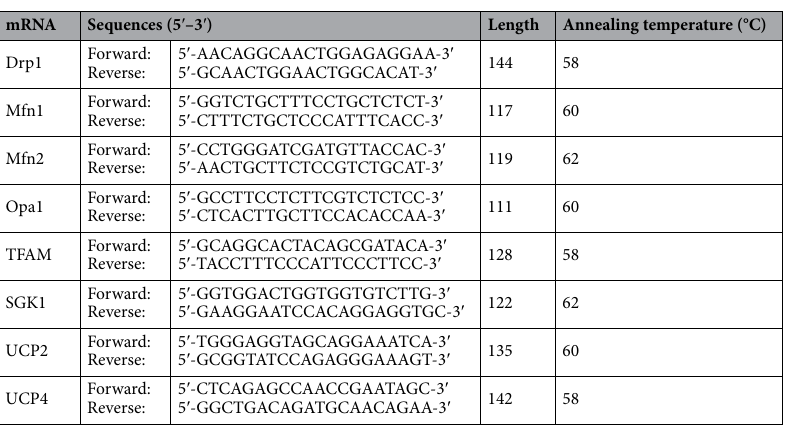
Table 1. Sequences of the primers employed for amplification of mRNAs encoding Drp1, Mfn1, Mfn2, Opa1, TFAM, SGK1, UCP2 and UCP4 by qRT-PCR.